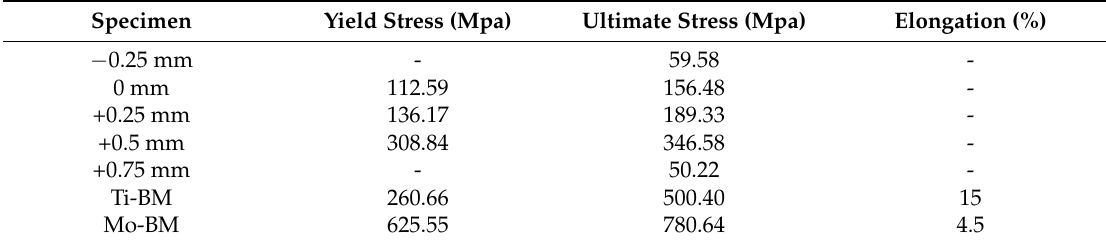
Figure 11. The shape and sizes of tensile specimens ( a ) and results of tensile tests: ( b ) tensile test results of Mo/Ti joints and the BM of titanium, ( c ) variation of average tensile strength of Mo/Ti joint against laser beam offset. Table 2. Tensile result of a group of welded joints and BMs.